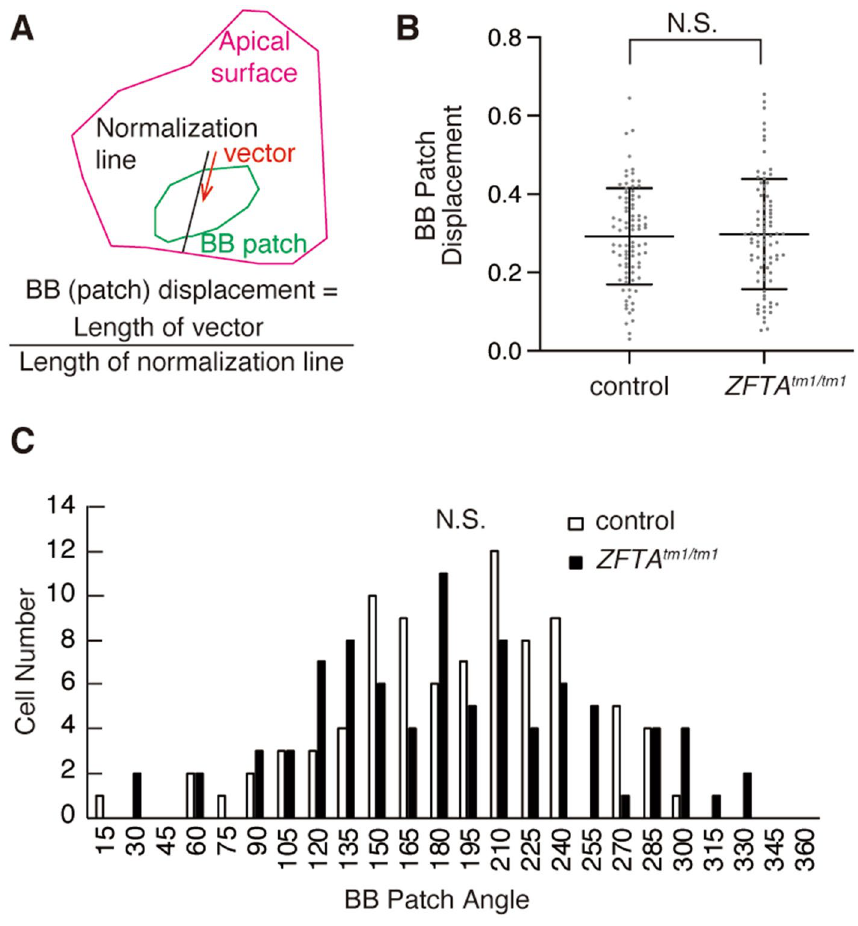
Figure 5. Normal translational polarity in Zfta tm/tm E1 cells. ( A ) Schematic drawing showing the BB patch angle and BB patch displacement. A vector (red arrow) was drawn from the centre of the apical surface to that of the BB patch. To calculate the BB patch displacement, the length of the vector was normalised with the length of the line extended to the edge of the apical surface (black line). ( B ) Quantification of the BB displacement. Data shown are the mean ± SD. Control; n = 87 E1 cells, 3 mice: Zfta tm1/tm1 ; n = 86 E1 cells, 3 mice; p = 0.78. Each point on the graph is the BB displacement of an individual E1 cell. N.S., not significant. ( C ) Histogram showing the distribution of BB angles in the controls [white bars, circular standard deviation (CSD) = 57.19, n = 87 E1 cells, 3 mice] and Zfta tm1/tm1 (CSD = 69.534, n = 86 E1 cells from 3 mice) E1 cells at P30–35. N.S., not significant ( p >